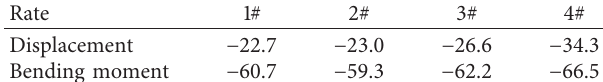
Table 7: Response difference rates for Case 2 and Case 4 (%). Rate 1# 2# 3# 4# Displacement − 22.7 Bending